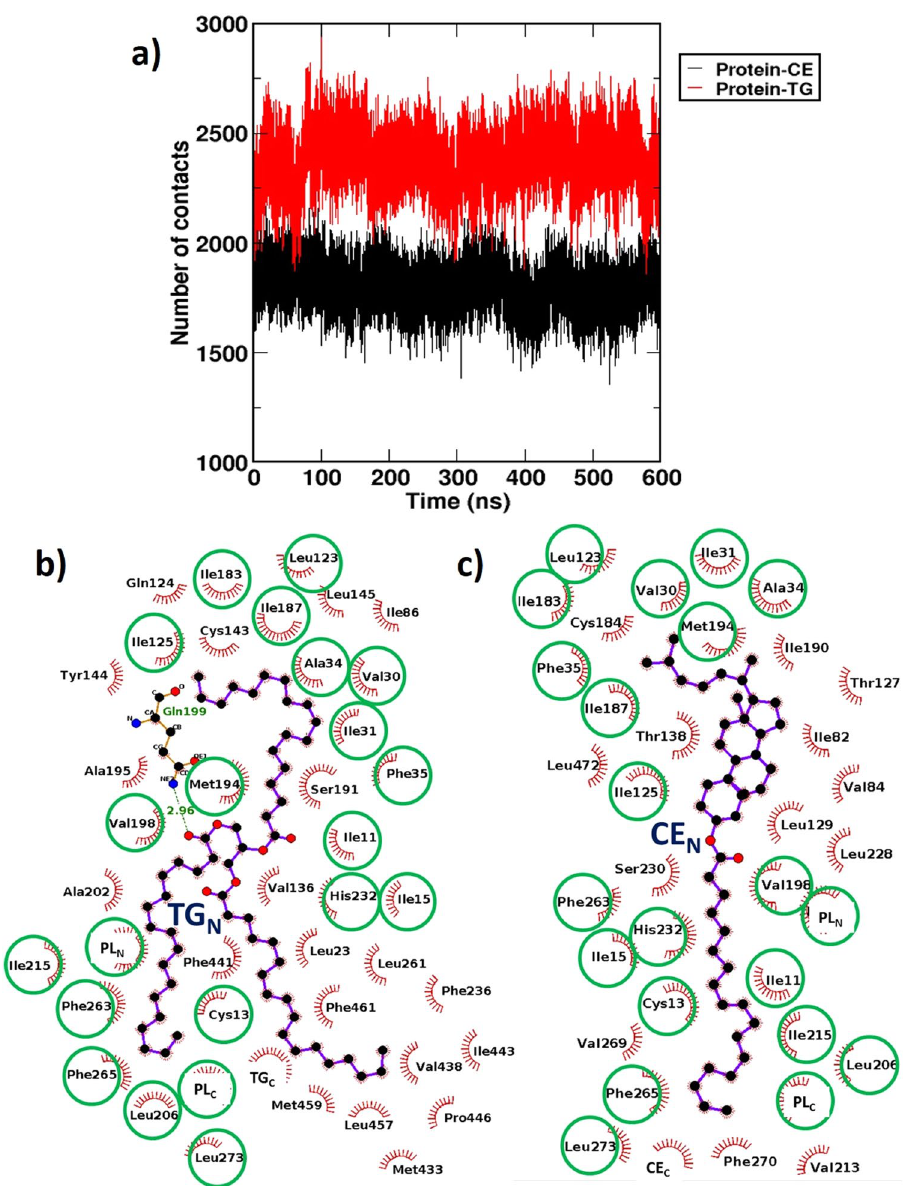
Figure 7. ( a ) Time evolution of the number of hydrophobic contacts formed by TG (red) and CE (black) with CETP. Protein-lipid contacts were estimated by counting the pairs of CETP and TG/CE sites that reside in close proximity with a chosen threshold distance of 5 Å. The interactions of CETP tunnel residues with ( b ) N-terminal TG in TG-CETP complex and ( c ) N-terminal CE in CE-CETP complex are shown for comparison. TG and CE are shown in ball-and-stick representation and protein residues involved in hydrophobic interactions are shown by red spikes. H-bonding interactions between TG and CETP residue Gln199 is shown by green dotted lines. Green circles denote the common interactions in both